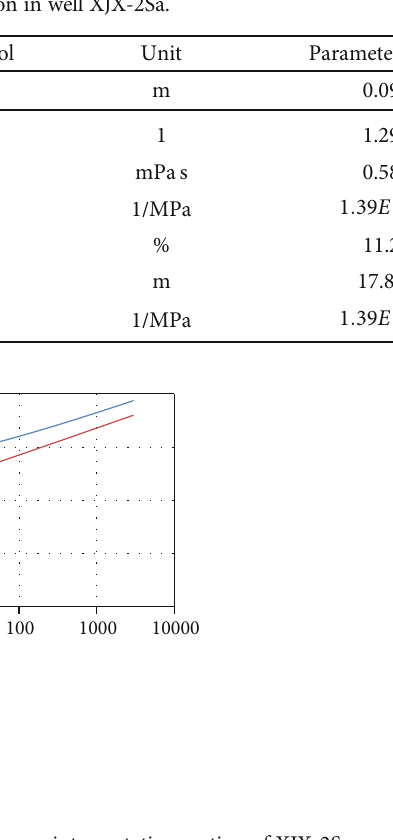
Table 4: Basic parameters of DST well-test interpretation in well XJX-2Sa.